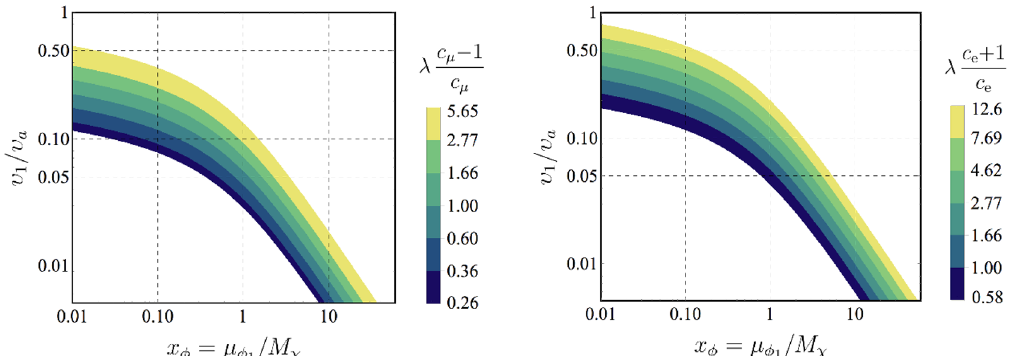
Figure 4 . Ratio (cid:29) 1 =(cid:29) a as function of x (cid:30) for the muon case (left panel) and the electron case (right panel). We have used eq. (2.10) with 1 = 2 < m FN (cid:21) [ (cid:25)= 6 ; 2 (cid:25) ]. For a given c ‘ , we can read the required value of (cid:21) from the bar 2